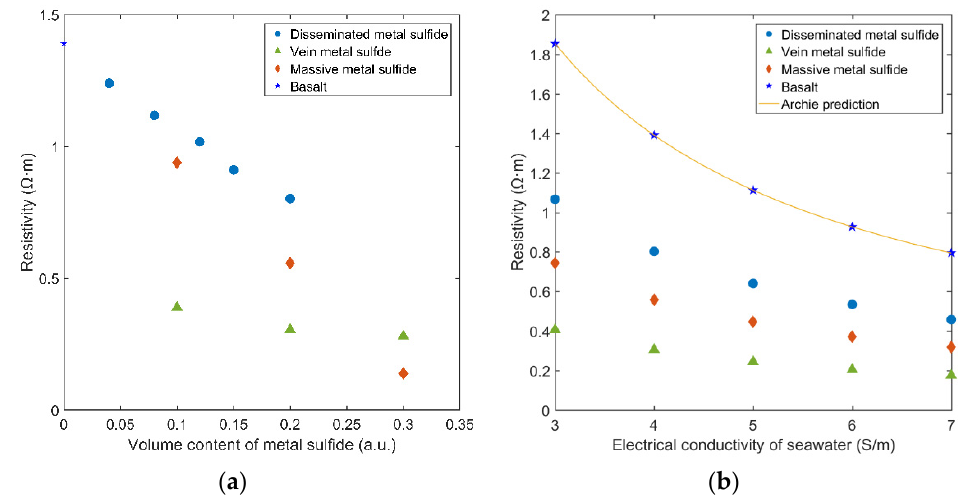
Figure 8. Dependence of the resistivities of seafloor sulfide-bearing rocks on the volume contents of metal sulfides and the electrical conductivity of seawater. ( a ) Resistivity versus volume content for the metal sulfides. ( b ) Resistivity versus electrical conductivity for seawater.